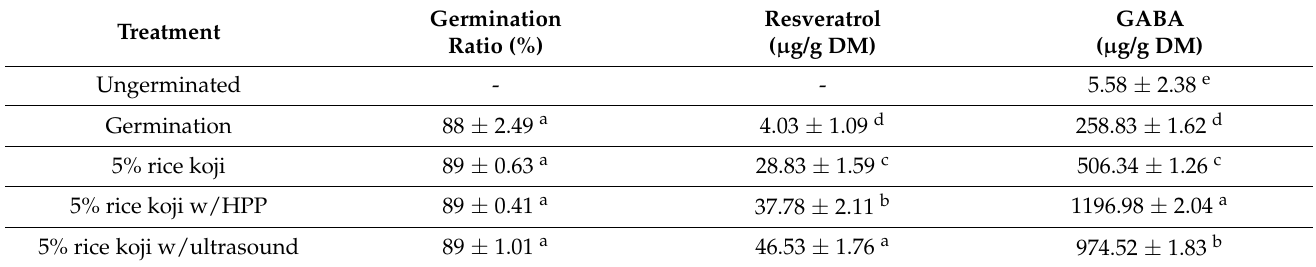
Table 6. Germination ratio, resveratrol, and GABA contents of germinated in rice koji with HPP or ultrasonic